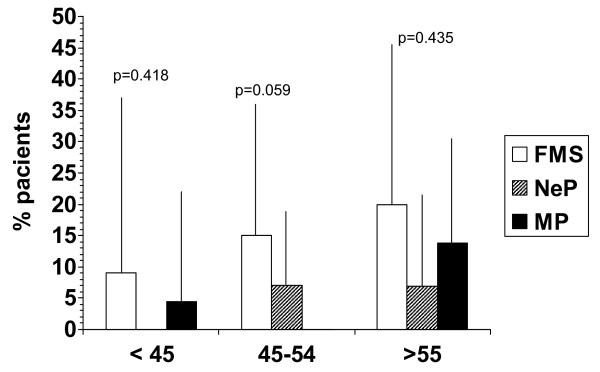
Frequency of cognitive impairment according to age and study group. FMS = Fibromyalgia Syndrome; NeP = Neurophatic Pain; MP = Mixed Pain. Bars are mean percentage with upper limit 95% CI.